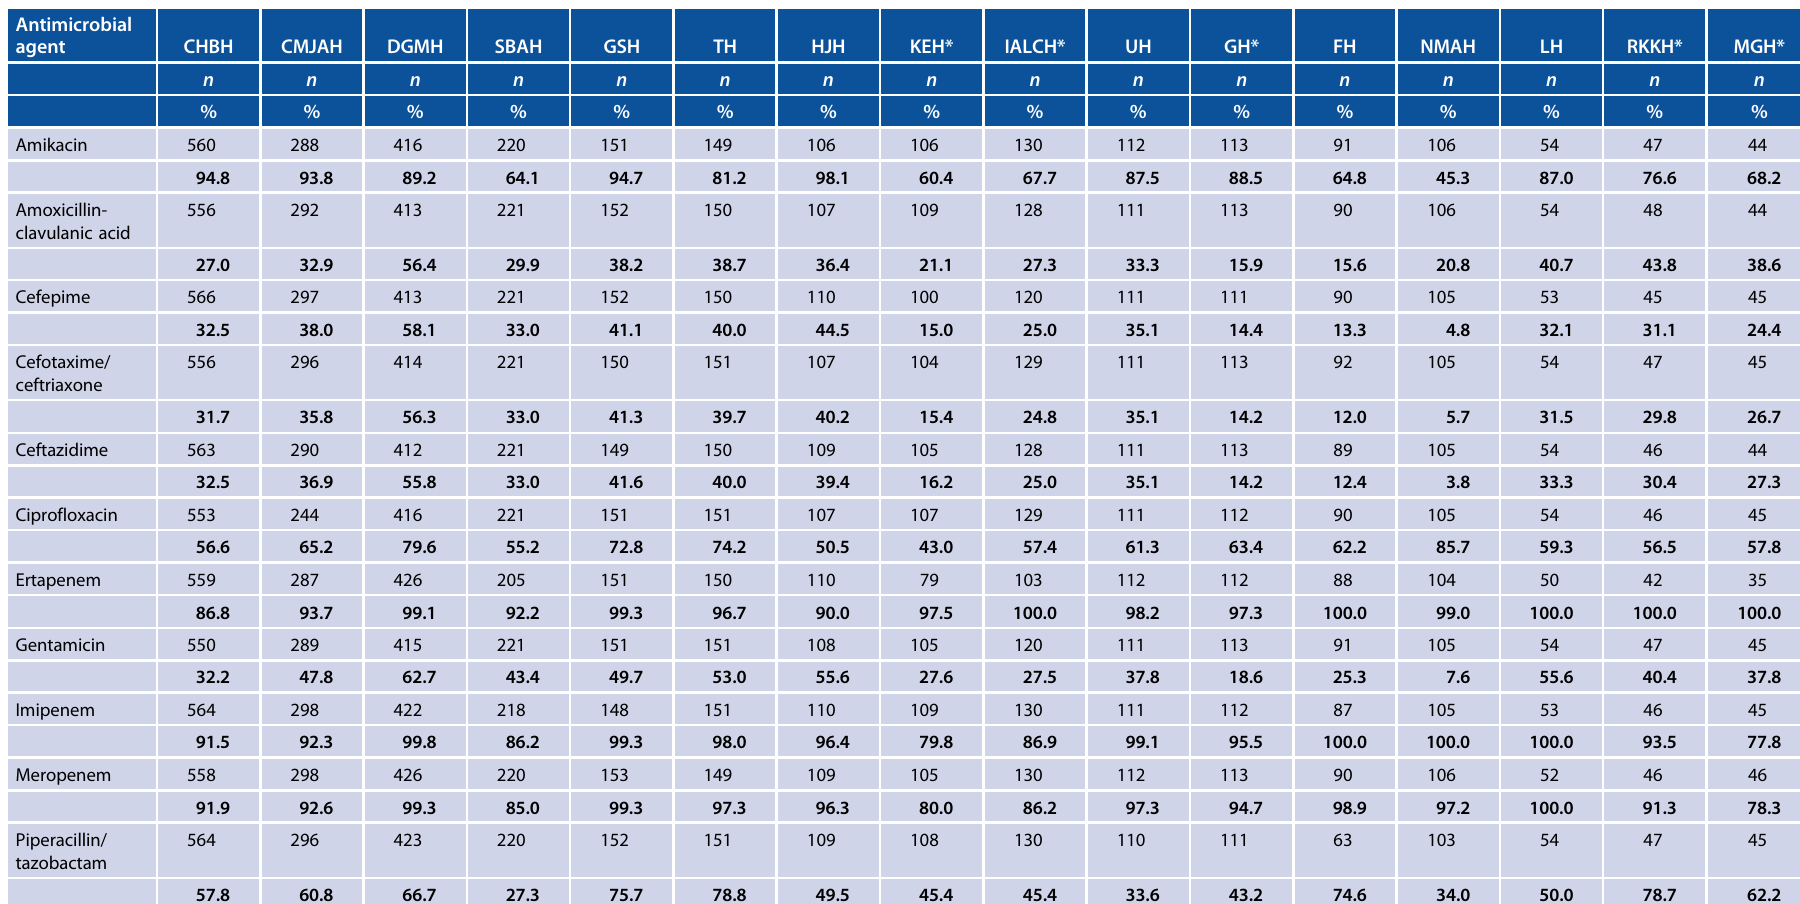
Table 4: Number and percentage of susceptible Klebsiella pneumoniae isolates per antimicrobial agent from 16 sentinel hospitals across South Africa, January 1, 2016 to December 31, 2016 Antimicrobial agent